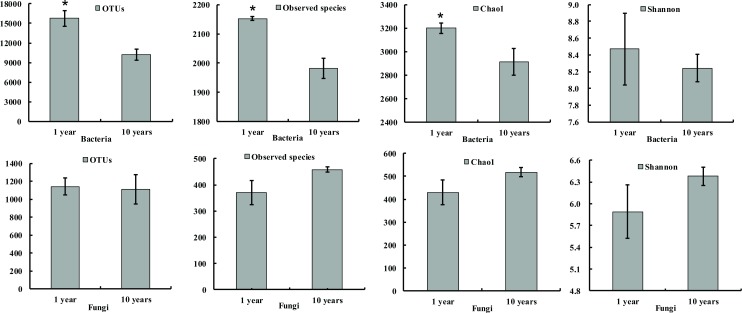
Comparison of OTUs and microbial (bacterial and fungal) diversity between the 1-year ramie soil and 10-year continuous-cropping ramie soil.Note: * represents significance at P < 0.05.